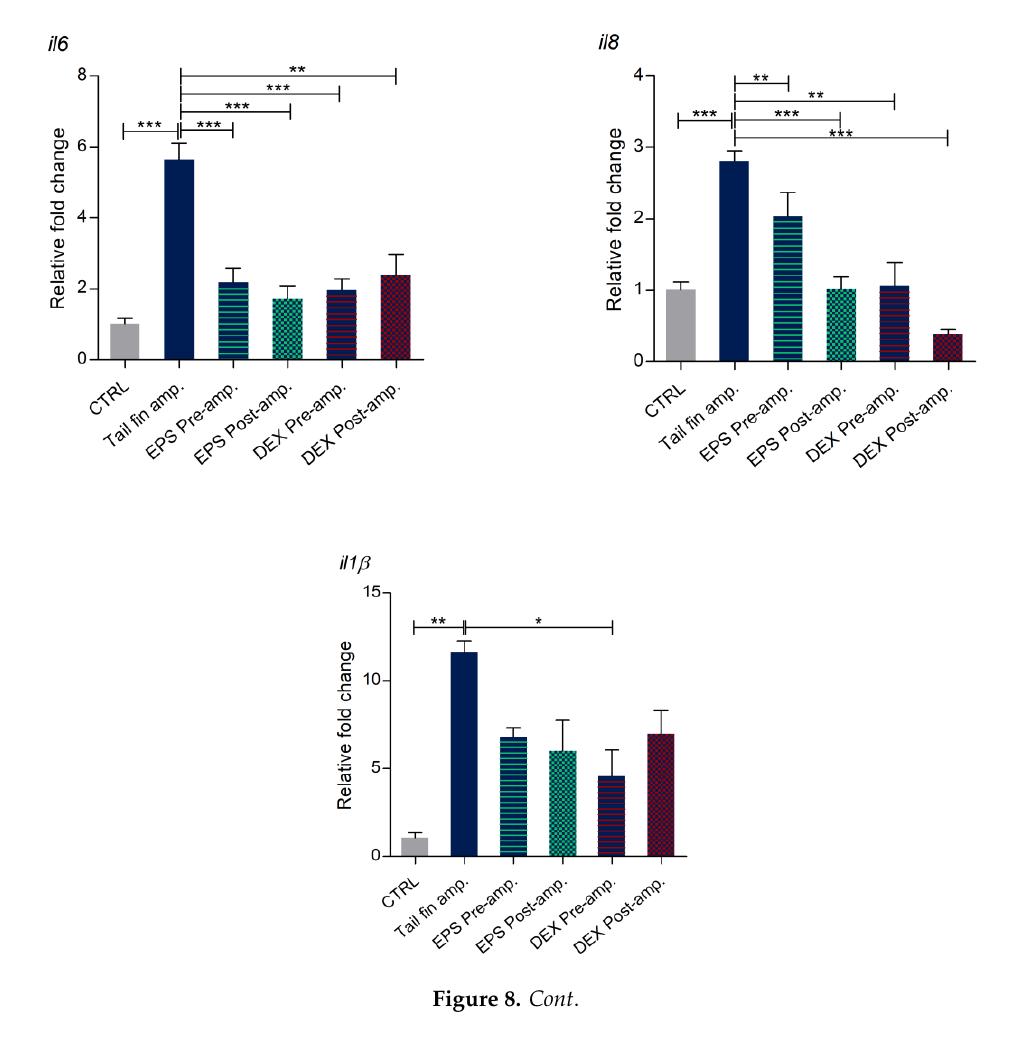
Figure 7. Anti-inflammatory effects of Phormidium EPS after caudal fin amputation induced inflammation in zebrafish larvae. ( A ) Recovery from inflammation was analyzed with the zebrafish transgenic line NFκB:GFP,Luc. EPS treatment determined a significant reduction of Luciferase activity recorded 48 h after fin amputation. ( B ) EPS treatment significantly decreased the number of neutrophils in the damaged area of 3 dpf tail fin amputated larvae in LysC:DsRed background.